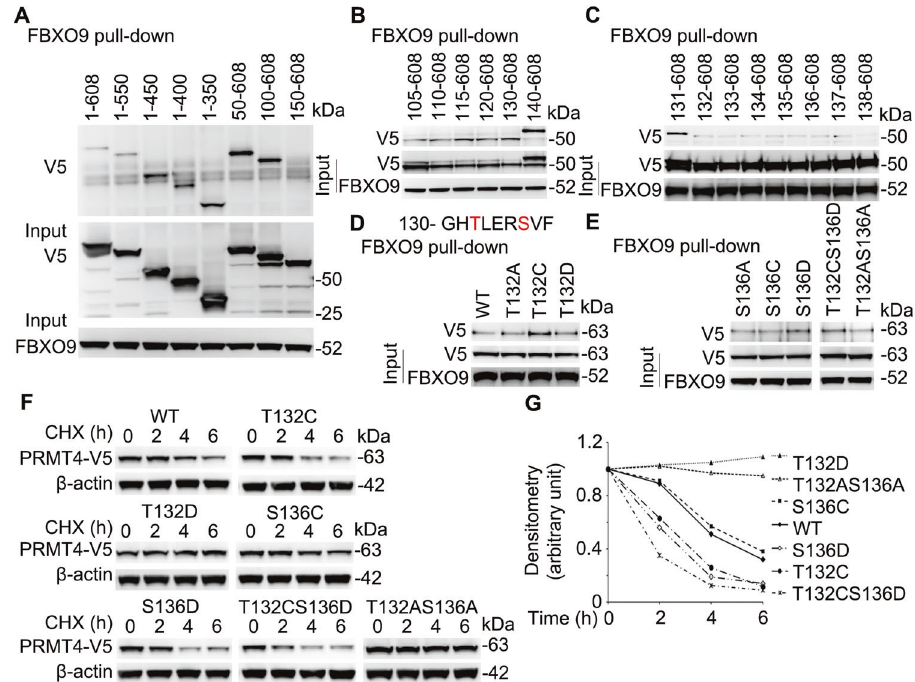
Fig. 5 FBXO9 docks on a phosphodegron 132TxxxS within PRMT4. A BEAS-2B cells were ectopically expressed with various deletion V5- PRMT4 plasmid constructs and lysates subjected to FBXO9 immunoprecipitation from MLE12 cell lysates and subsequent V5 immunoblotting to assess FBXO9:V5 interaction. Pull-down assays suggest that aa100 – 150 of PRMT4 is important for FBXO9 binding. B , C Fine mapping the FBXO9-binding sites with pull-down assays indicate that a phosphodegron 132TxxxS is critical for FBXO9 binding. D , E Pull-down assays with phosphorylation/dephosphorylation mimics indicate that T132 dephosphorylation and S136 phosphorylation promote the degron binding to FBXO9. F T132 dephosphorylation and S136 phosphorylation accelerate PRMT4 degradation using cycloheximide (CHX). G Densitometric results of F were plotted. Experiments n =